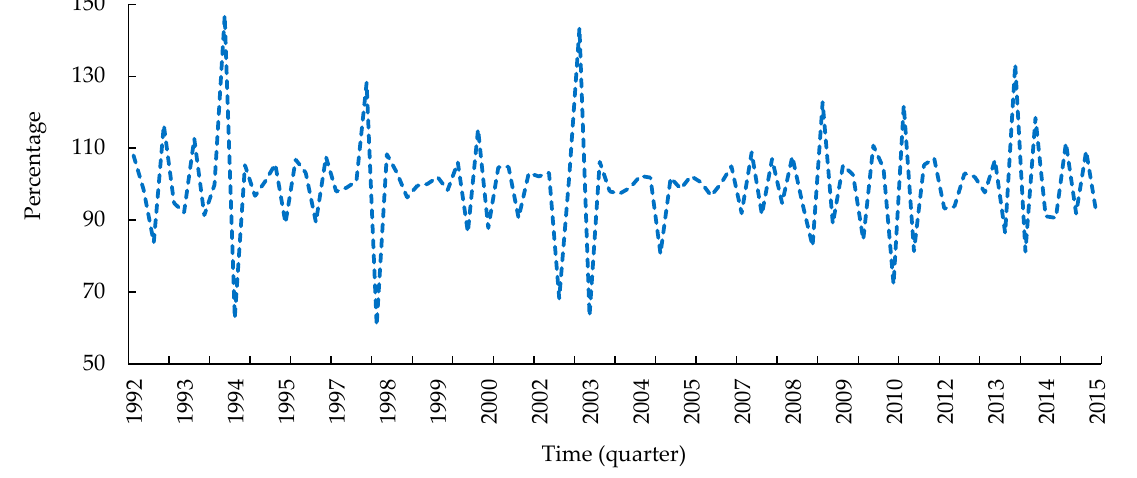
Figure 5. Decomposition of time series of lumber price, including seasonal fluctuation indices in Hyrcanian forest in 1992–2015.